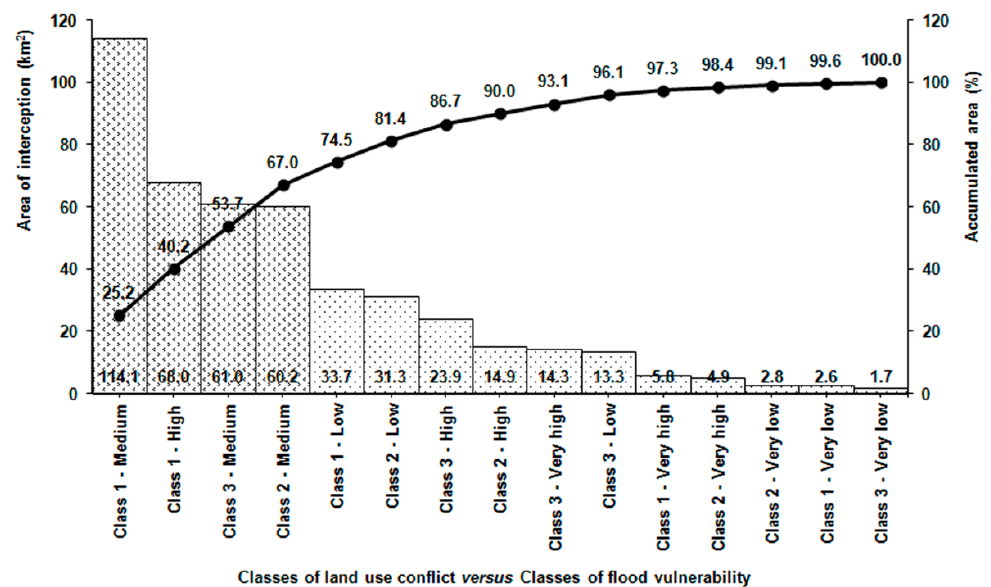
Figure 7. Pareto diagram illustrating the frequency of land use conflict versus flood vulnerability classes in the municipality of Batatais SP.